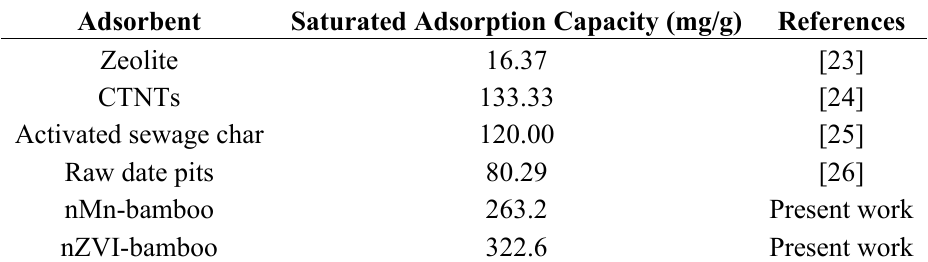
Table 4. Saturated adsorption capacities of MB for some